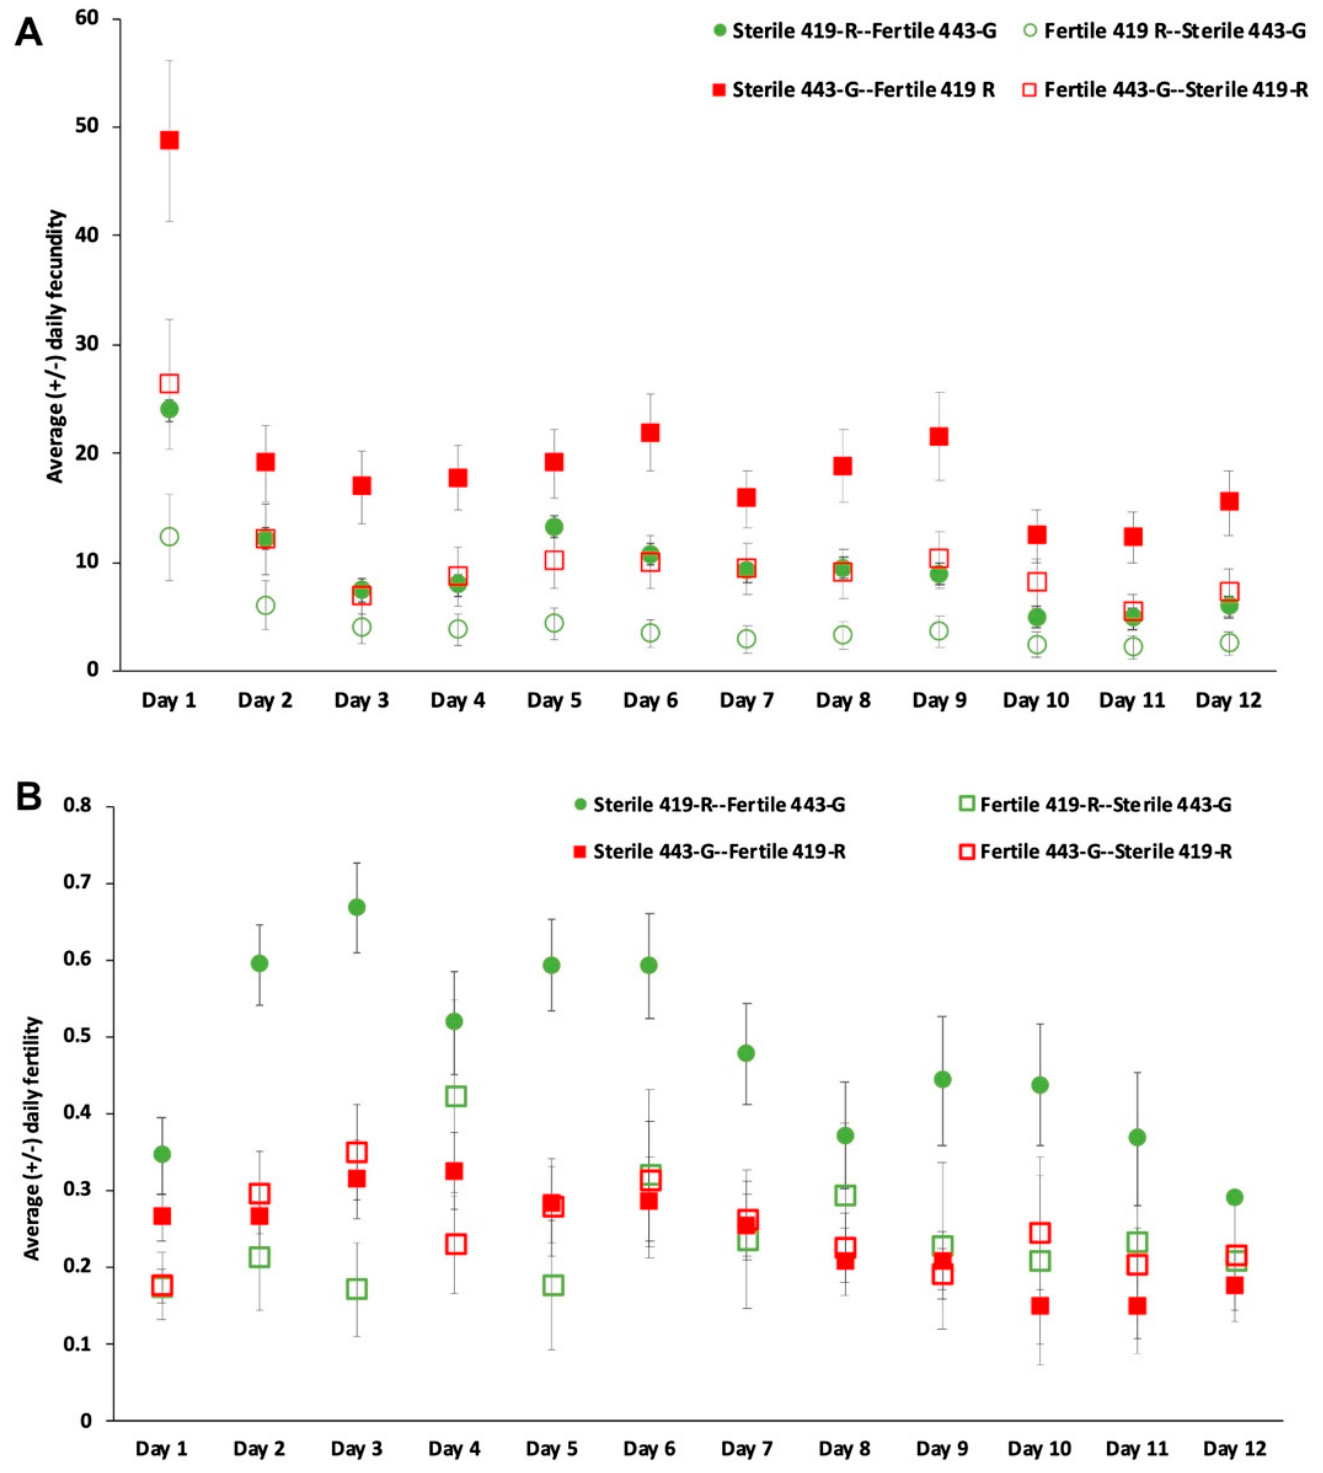
Figure 4. Daily average ( ± std. error) of ( A ) fecundity (eggs laid), and ( B ) fertility (eggs hatched/eggs laid) for A. ludens females that mated first with either a sterile 419-R male and then a fertile 443-G male (green circle); a fertile 419-R and then a sterile 443-G male (open green circle); a sterile 443-G male and then a fertile 419-R male (red circle); or a fertile 443-G and then a sterile 419-R male (open red circle).